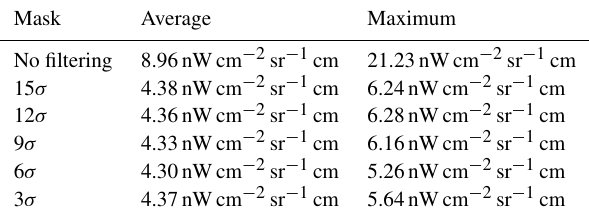
Table 3. Average noise value of a 0.625cm − 1 spectral sample and maximum noise of a superpixel averaged over all 0.625cm − 1 spec- tral samples for different bad-pixel masks. The smaller the n in nσ , the more the pixels will be